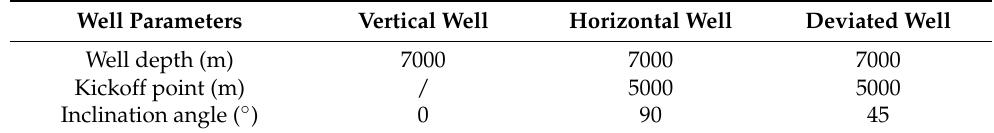
Table 7. Basic well trajectory parameters.